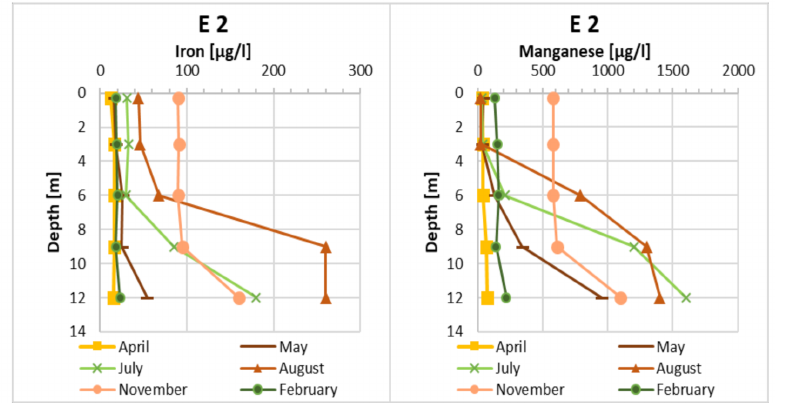
Figure 6. Iron and manganese distribution in the water column of Lake Eichbaumsee at location E2 between April 2018 and February